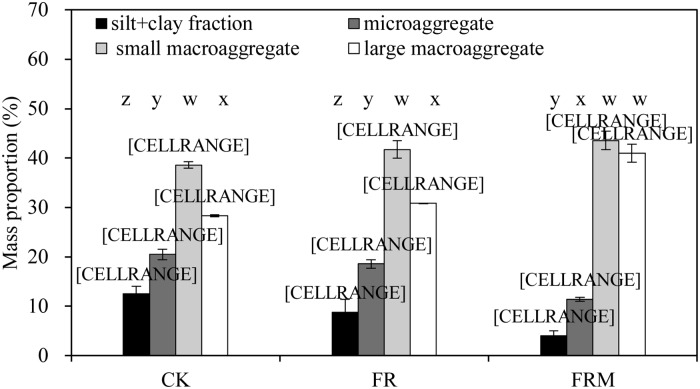
Mass proportion (%) of soil aggregates in 0- to 20-cm bulk soil affected by compost and inorganic fertilizer.Vertical bars denote the standard error of the mean (n = 3). Different letters a, b and c indicate significant differences between treatments for the same aggregate at P < 0.05. Different letters w, x, y and z denote significant differences between aggregates for the same treatment at P < 0.05.